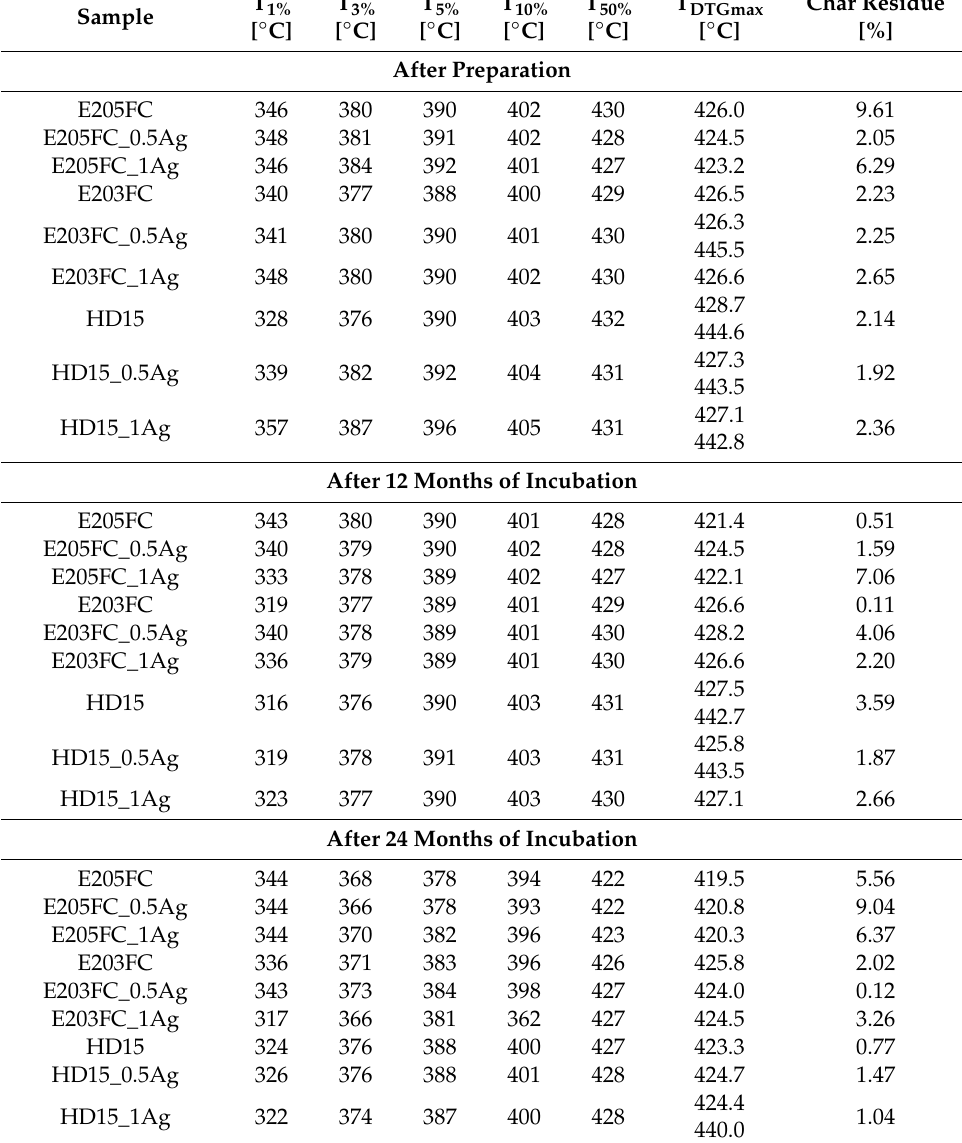
Table 2. Thermal stability of pure polymer (HD15) and polymer containing 1.0 wt % of silver nanoparticles AgNPs before incubation, after 12 months and after 24 months of